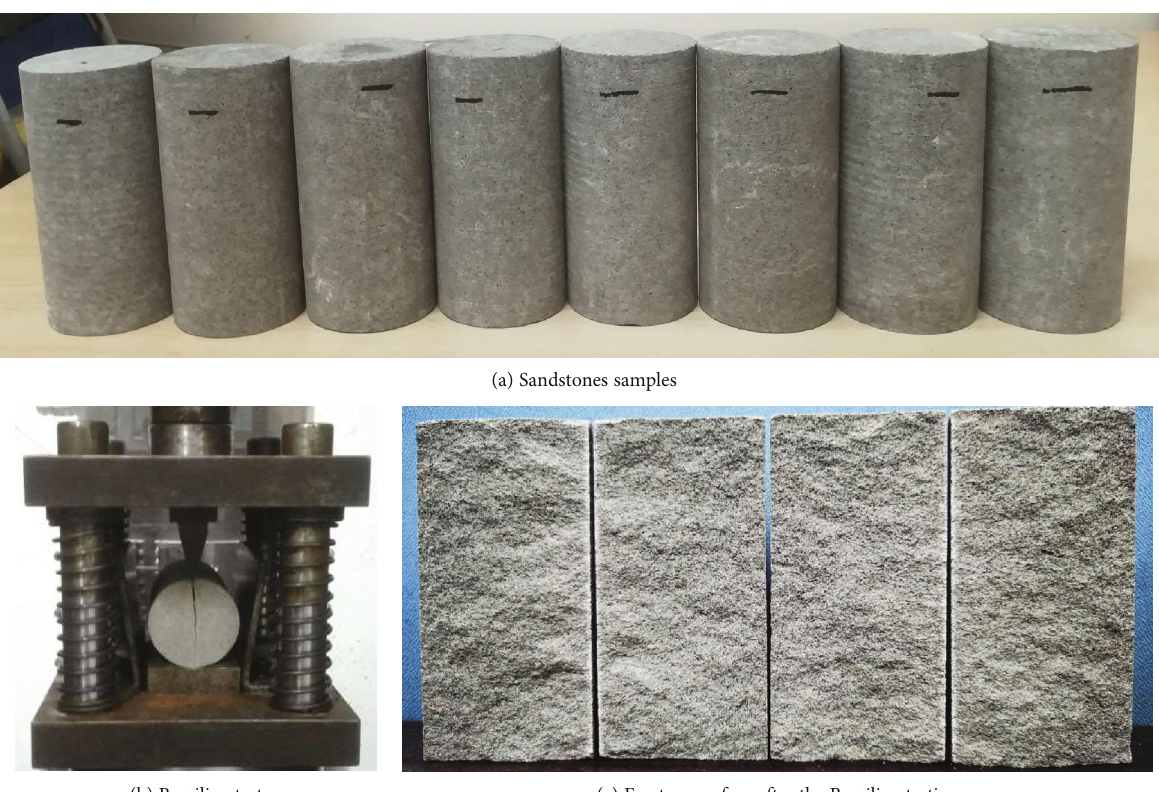
Figure 1: Arrangement of rock rough